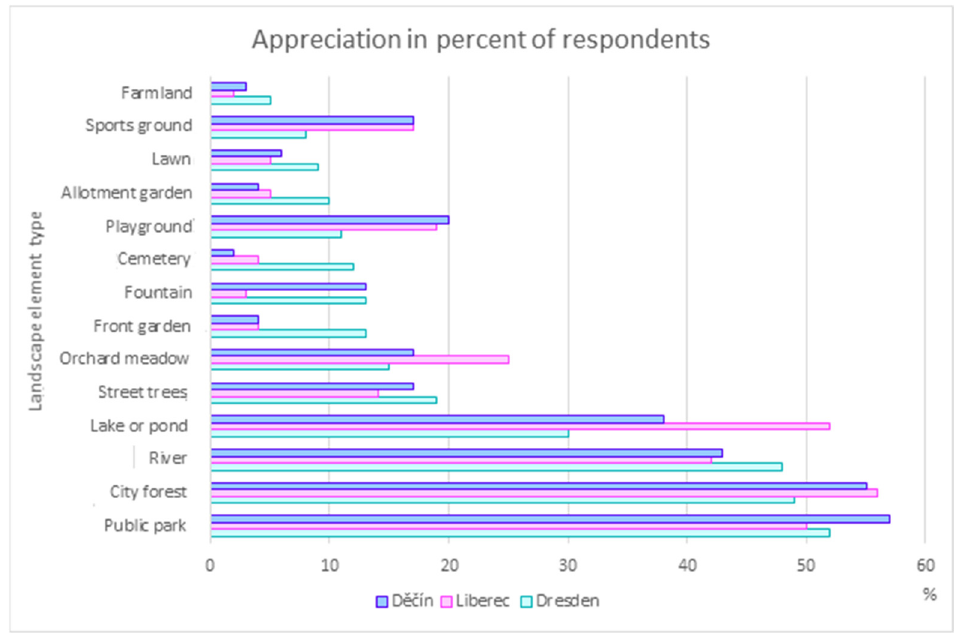
Figure 8. Landscape element types and their appreciation (Table 6) (source: authors’ elaboration).